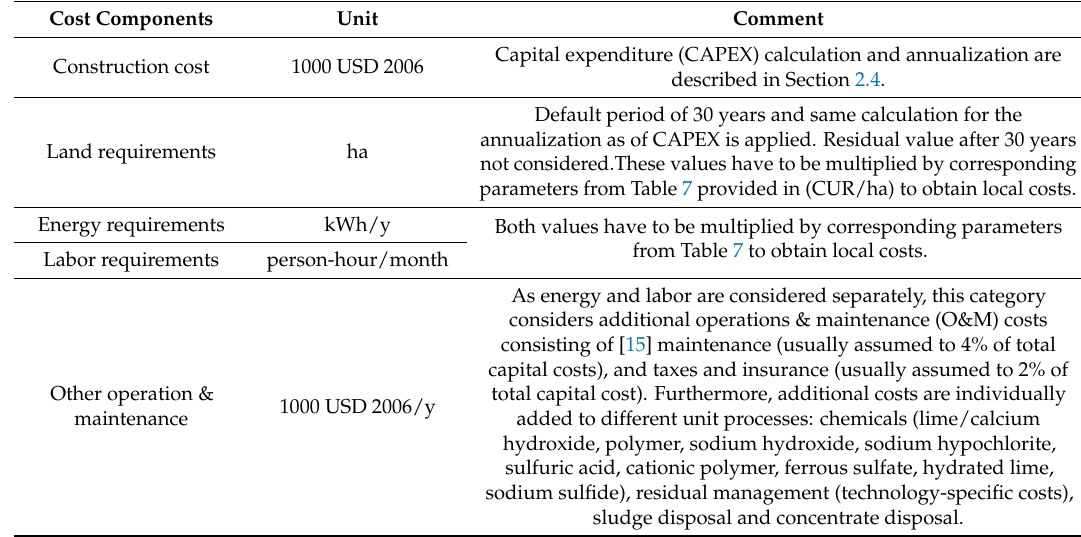
Table 6. Cost components included in the